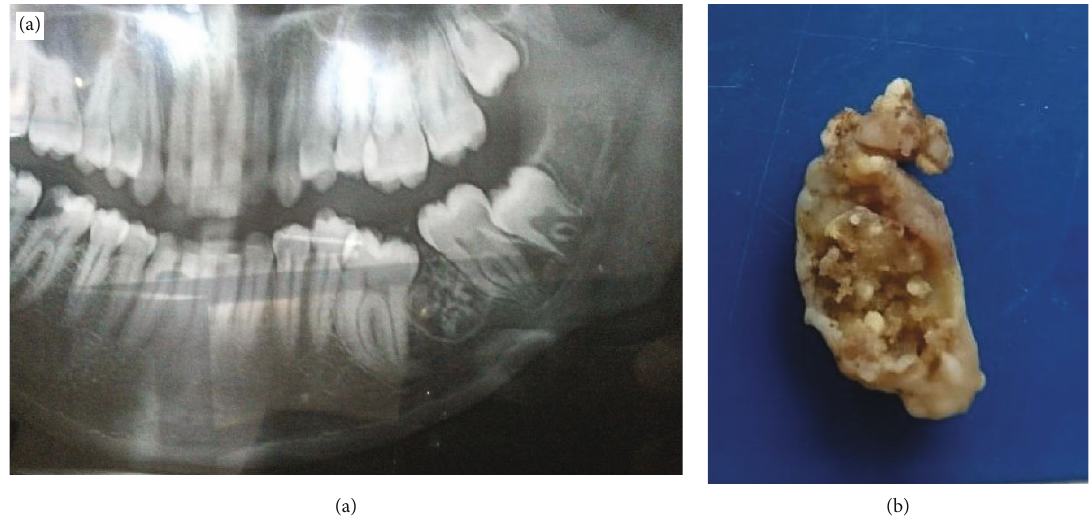
Figure 7: (a) OPG shows impacted 36 with a well-de fi ned radiolucent lesion with specks of radioopacity in interradicular area of 36 and 37. (b) Grossing shows solid tissue with hard